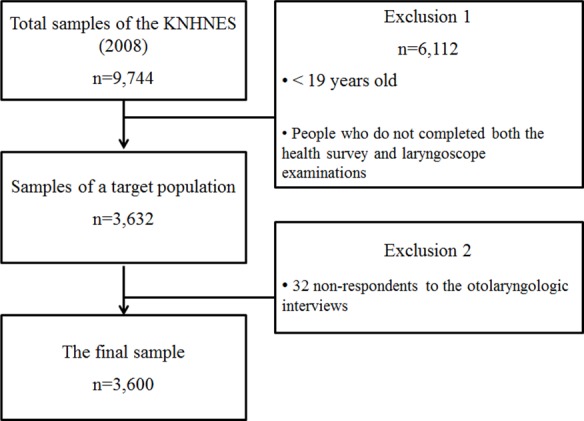
The flow chart of the study.